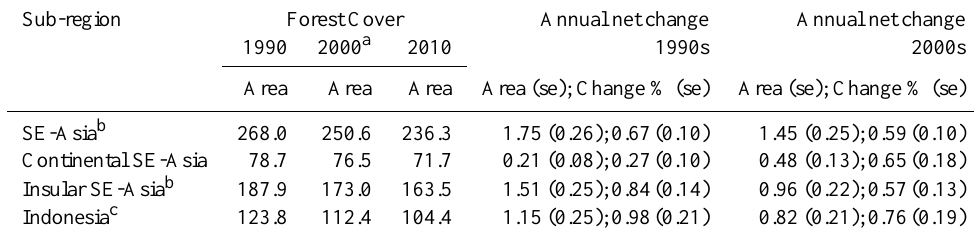
Table 3. Forest cover and annual change in Southeast Asia and sub-regions (areas in